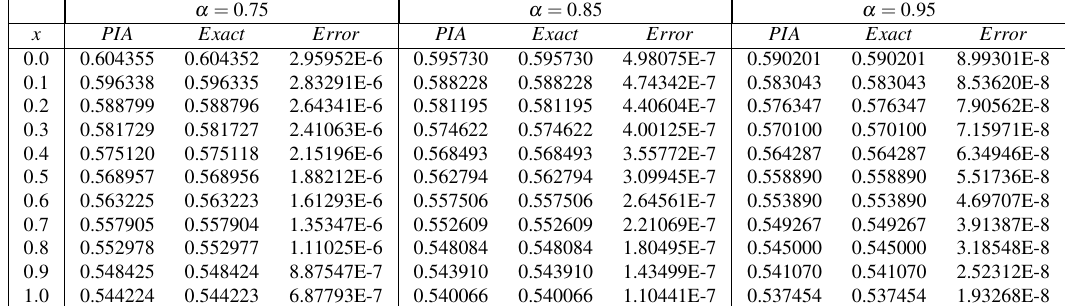
Table 2 PIA ( v 4 ( x , y , t ) ) and exact solution values with absolute errors for y = 1 , t = 0 . 1 and ℜ = 100 . α = 0 .